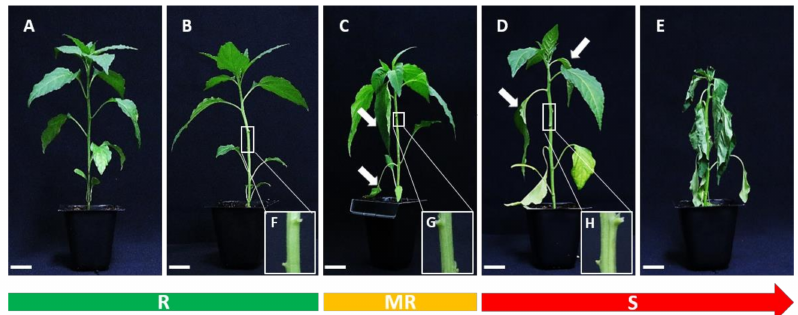
Figure 3. The disease symptoms scale ranging from 0 to 4 for BW evaluation. ( A – E ) Photographs representing 0 (no symptoms) to 4 (complete wilting) wilt symptoms stages. ( F – H ) The enlarged photographs of stem with abscission of leaves after R. solanacearum inoculation. The BW phenotype of three stages denoted resistance (R) with a green bar, moderate resistance (MR) with a yellow bar, and susceptible (S) with a red bar. The white arrows indicate wilt and abscission leaves. The white under bar signifies 2